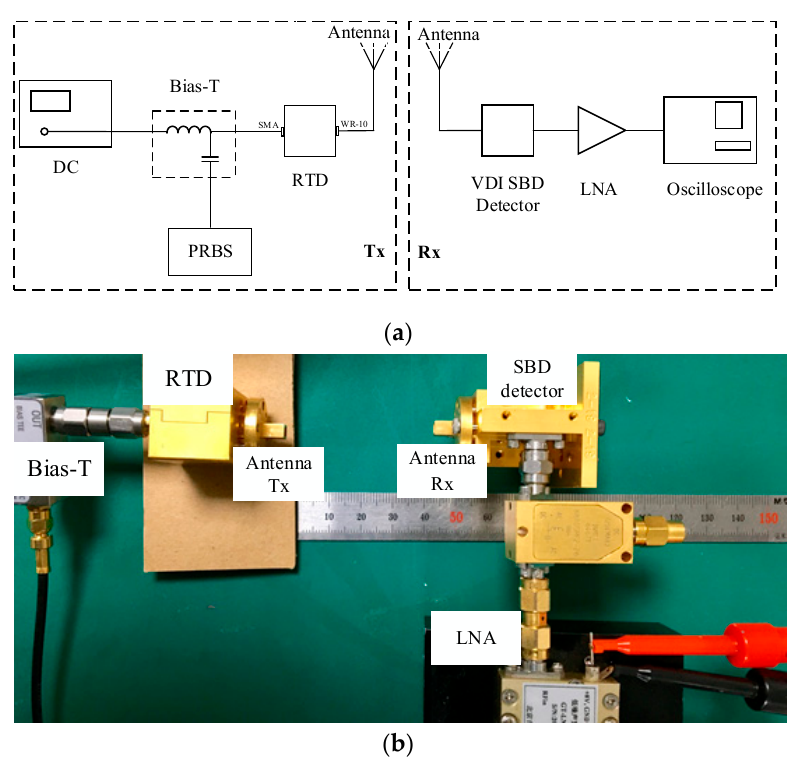
Figure 12. High-integrated wireless communication system. ( a ) Block diagram; ( b ) Photograph. Electronics 2020 , 9 , x FOR PEER REVIEW